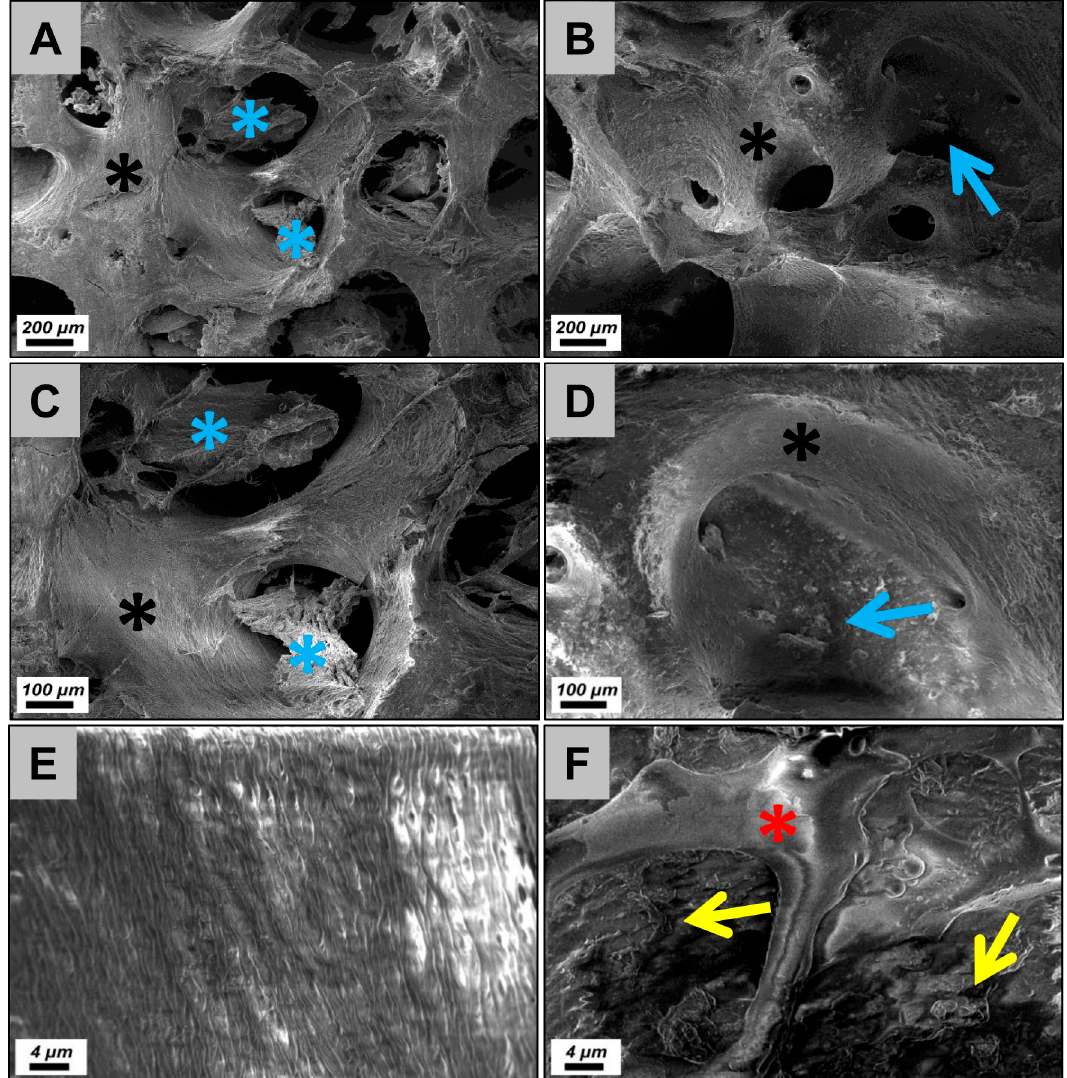
Figure 1. Scanning electron microscopy (SEM) images of the two bone blocks. The analysis revealed that the maxgraft ® block (black asterisks = calcified bone matrix) contained high amounts of intertrabecular collagen (blue asterisks) ( A and C ), while only some collagen spots (blue arrow) were found in case of the SMARTBONE ® block ( B and D ). Moreover, the SEM analysis showed that the maxgraft ® bone block exhibited a fibrillar surface texture ( E ), while island-like areas of the added polymer (red asterisks in F ) and some loosely distributed collagen fibers were observable in case of the SMARTBONE ® block ( A and B : 50 × magnification, C and D : 100 × magnification, E and F : 2000 × magnification).